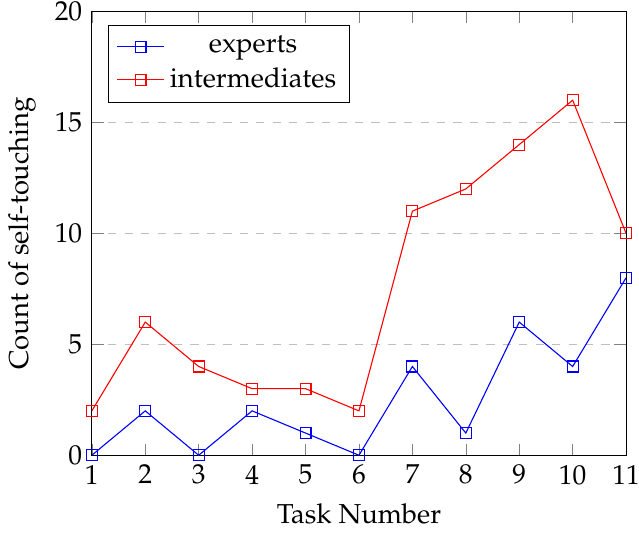
Figure 6. Count of self-touching in regard to the task (1–11). Tasks are ranging in an increasing difficulty order.